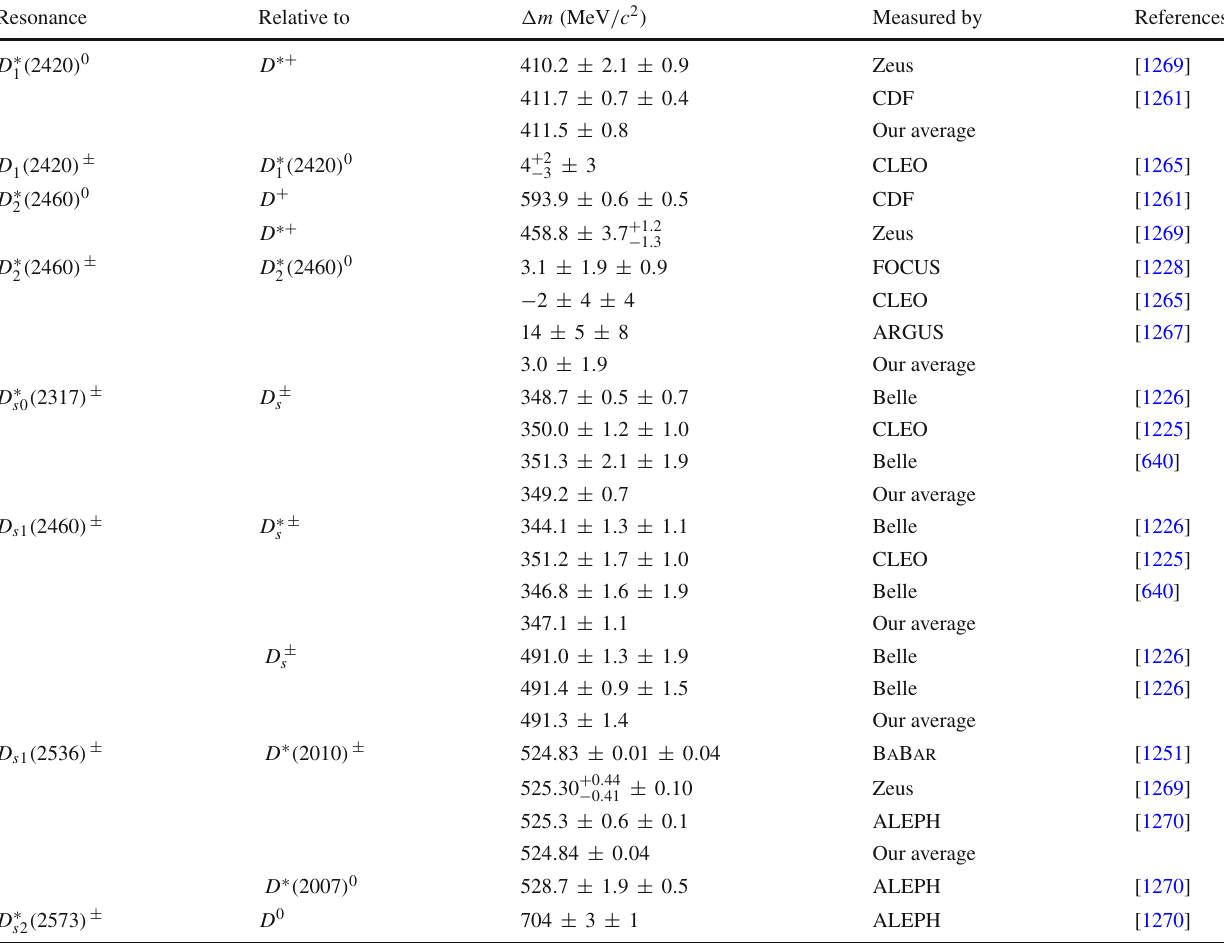
Table 294 Mass difference measurements for excited D mesons Resonance